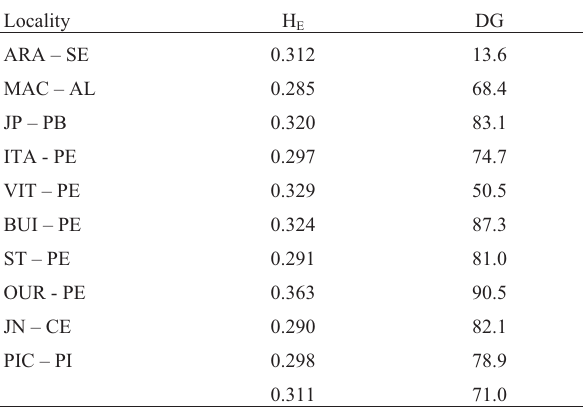
Table 4 - Genetic diversity (GD) and mean heterozygosity (H E ) estimated for the analyzed populations of Rhammatocerus brasiliensis . Locality